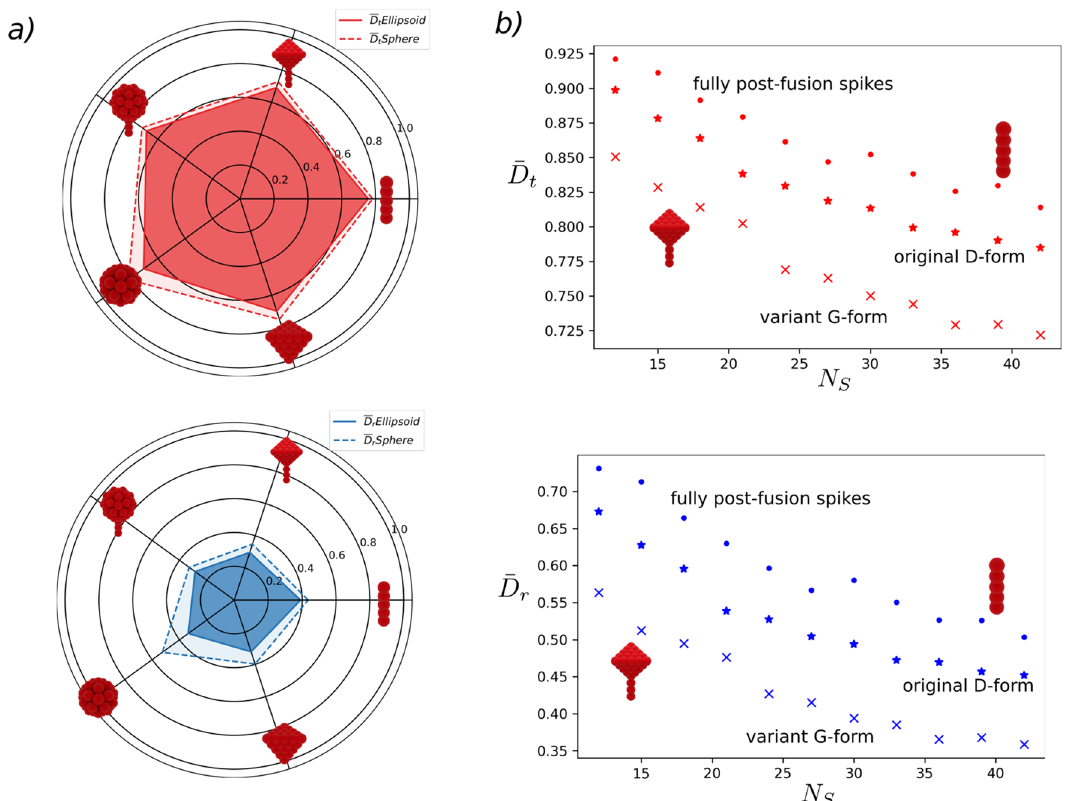
Figure 2. Effect of S morphology on the mobility of virions. ( a ) Comparison of the reduced translational and rotational diffusion for the different S shapes for virions with N s = 12 , and l s / R = 0.4 , homogeneously distributed. Ellipsoidal envelopes exhibit slightly larger deviations on the rotational diffusion than spherical envelopes due to their small asymmetry. The differences in ¯ D t between S shapes do not reveal a significant difference. In contrast, for ¯ D r , small but observable differences indicate the potential use of the rotational diffusion of virions as a rheological biomarker. ( b ) Variation on ¯ D t and ¯ D r with N s for fully postfusion (rod), fully prefusion (rod-tetra) and mixed postfusion/prefusion S . The diffusion coefficient values for each N s are obtained from ten independent realizations with S randomly distributed on the envelope. The fraction of postfusion S in the mixed case corresponds to the original D-forms of SARS-CoV-2, N s | post / N s = 0.7 . Fully prefusion case is consistent with mutated G-forms characterized by N s | pre / N s ∼ 1 . Regardless of the differences in S morphology, the reduction in both ¯ D t and ¯ D r exhibits the same functional dependence as N s increases. However, the magnitude of the mobility reduction is larger for the full-prefusion